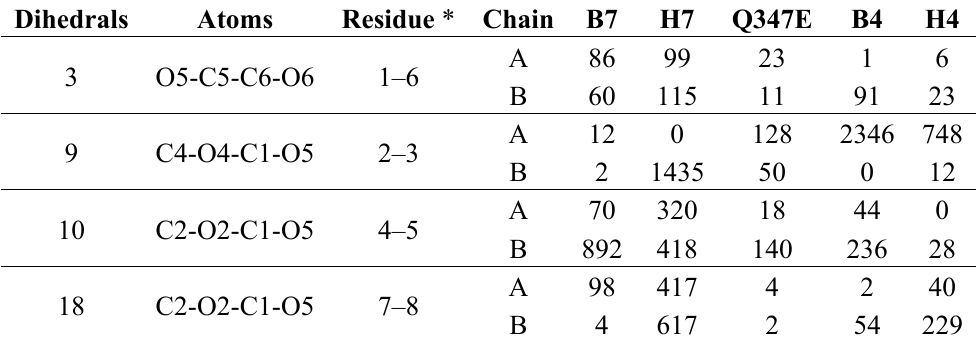
Table 1. Dihedral angle transitions in the glycan tree which show a significantly higher number of transitions between energy